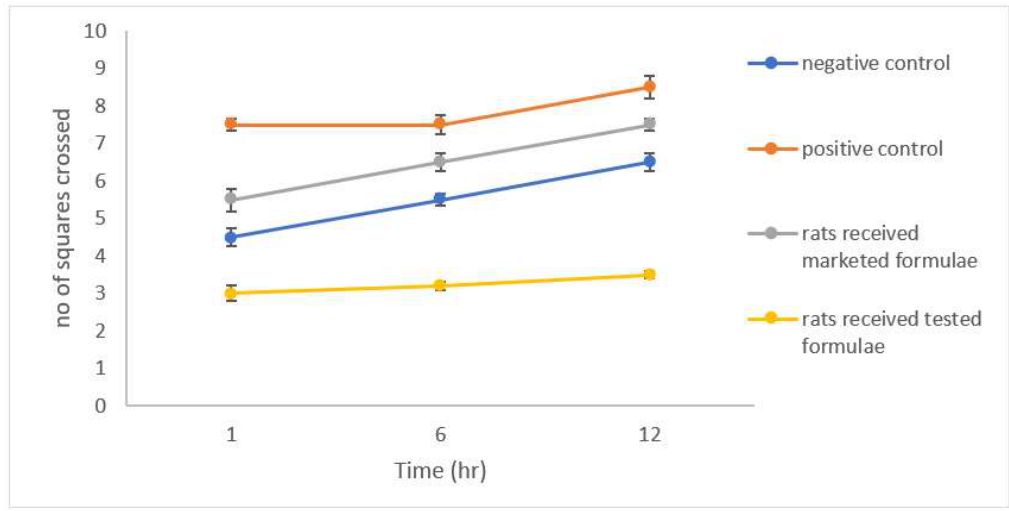
Figure 9. Number of squares crossed by different groups of rats .